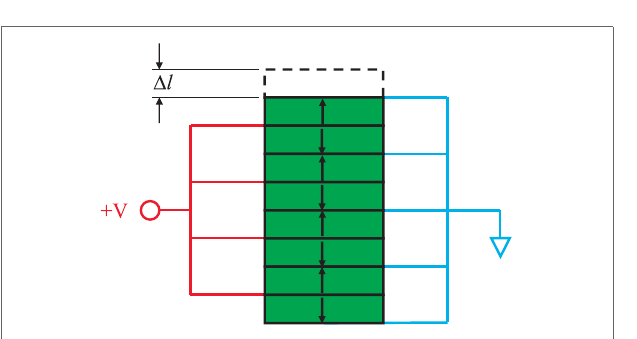
FIGURE 2 | A piezoelectric stack actuator mechanically bonded in series, and electrically connected in parallel .